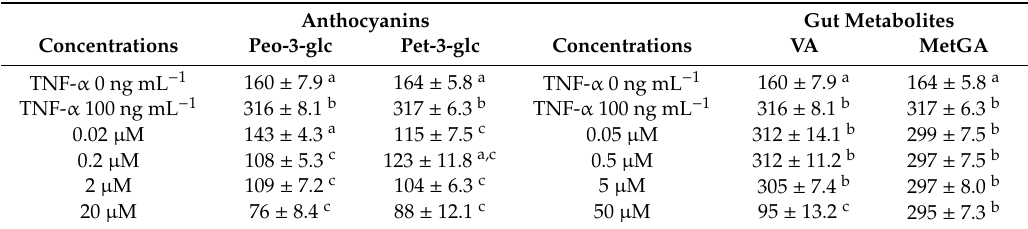
Table 2. E ff ect of peonidin-3-glucoside, petunidin-3-glucoside, vanillic acid and methyl-gallic acid on the levels of E-selectin.